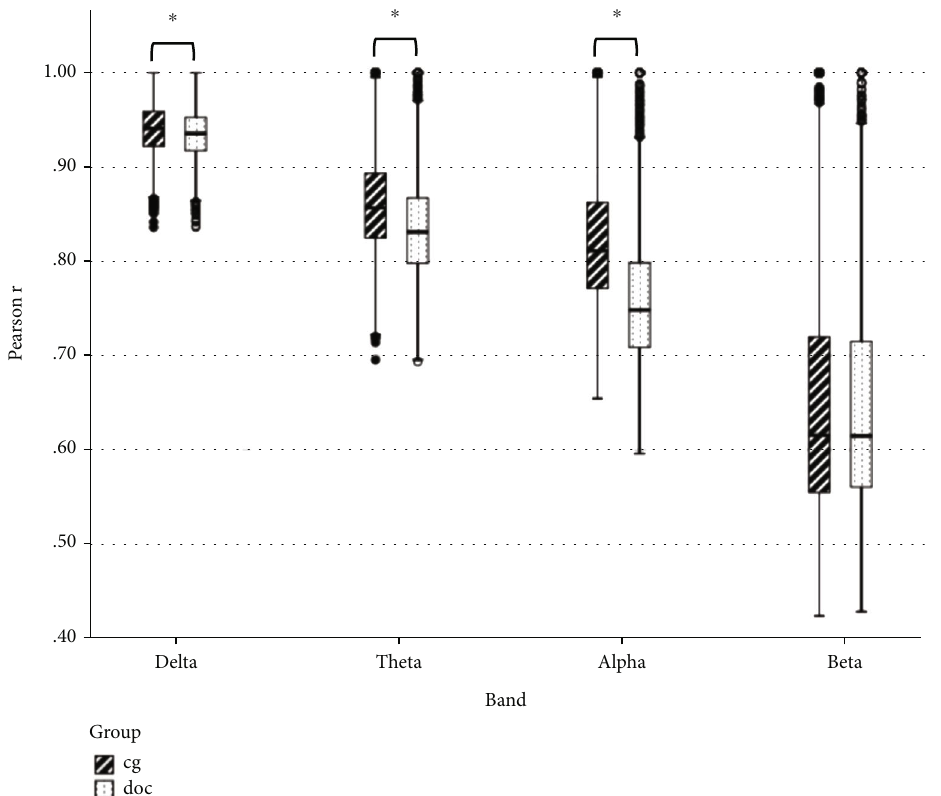
Figure 6: The Pearson r results using Mann – Whitney U test. Delta, theta, and alpha bands are statistically signi fi cant. ( ∗ represents P < 0 : 05